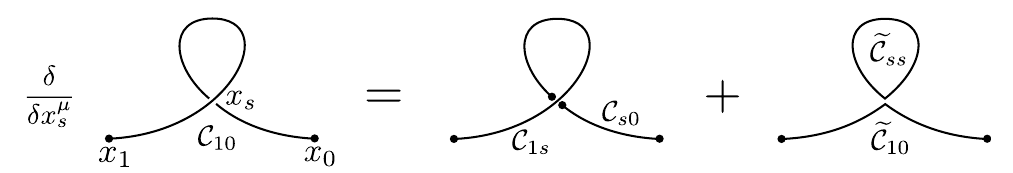
Figure 16 . The evolution equation for a mesonic line operator with a Wilson line along the path C 10 , is given in (6.5). Local functional variation of the path result in the insertion of the field strength operator. When substituting the equation of motion F = J , an additional contact term contributes at self-crossing points. In the planar limit, both terms factorize into a product of two lines. In particular, the self crossing term factorize into a product of a closed Wilson loop W [ e C times a mesonic line along the path e C in the 10